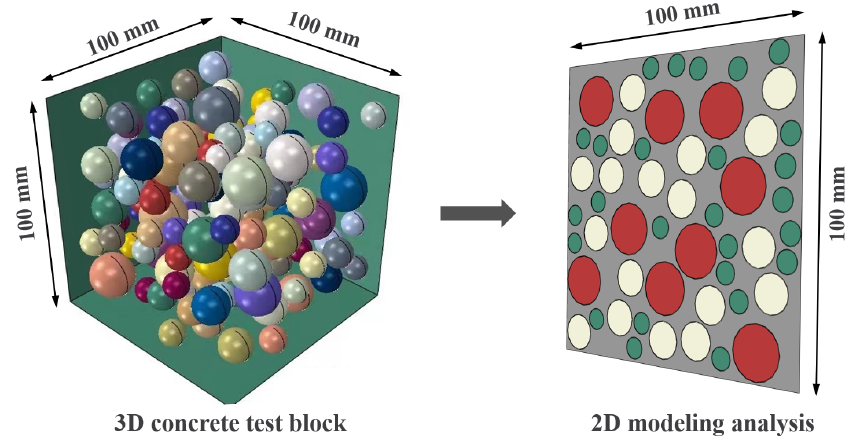
Figure 19. The simplification of concrete specimens from 3D to 2D models.